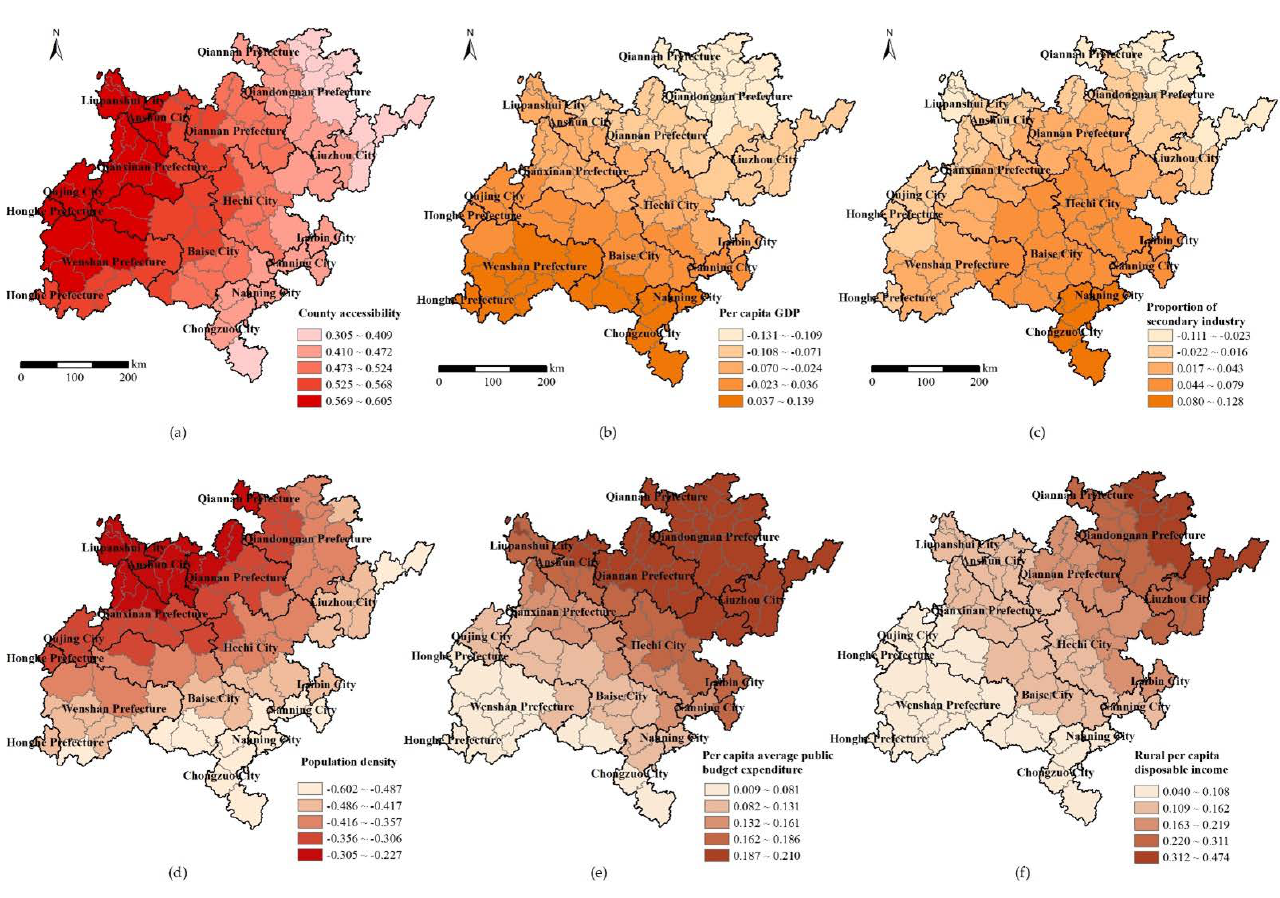
Figure 5. Spatial distribution of regression parameters for accessibility of educational facilities in the YGGRD: ( a ) County accessibility; ( b ) Per capita GDP; ( c ) Proportion of secondary indus- try; ( d ) Population density; ( e ) Per capita general public budget expenditure; ( f ) Rural per capita disposable